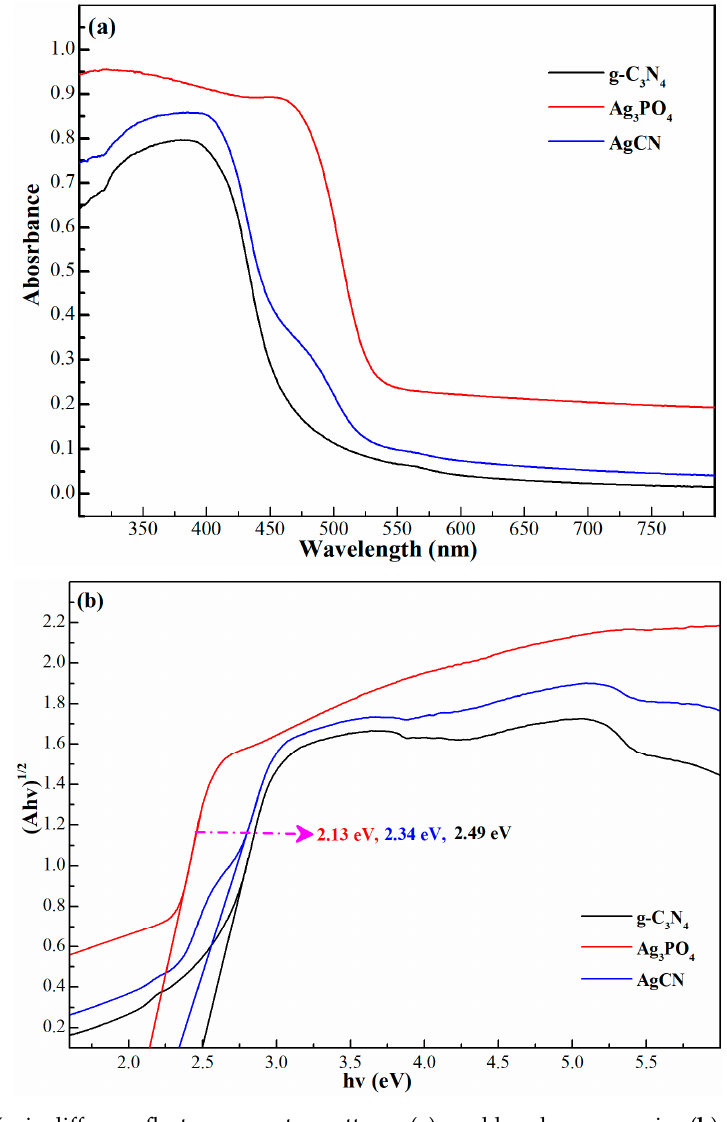
Figure 4. UV–vis diffuse reflectance spectra patterns ( a ); and band gap energies ( b ) of the g-C 3 N 4 (black line), Ag 3 PO 4 (red line) and AgCN photocatalysts (blue line).